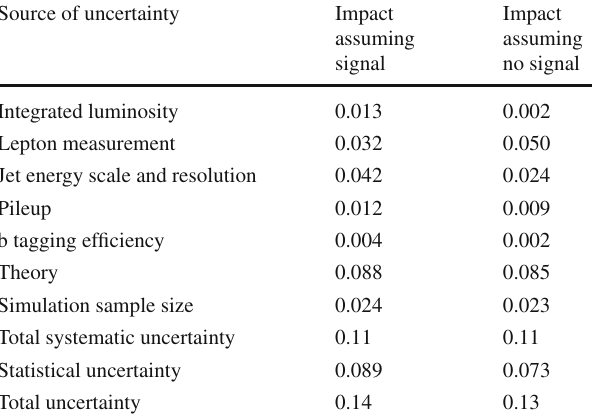
Table 2 Summary of the uncertainties in the branching fraction arising from the systematic uncertainties considered in the Zh ( invisible ) model assuming B ( h → invisible ) = 1(signal)and B ( h → invisible ) = 0(no signal).Here,leptonmeasurementreferstothecombinedtrigger,lepton reconstructionandidentificationefficiencies,andtheleptonmomentum and electron energy scale systematic uncertainty. Theory uncertainties include variations of the renormalization and factorization scales, α s